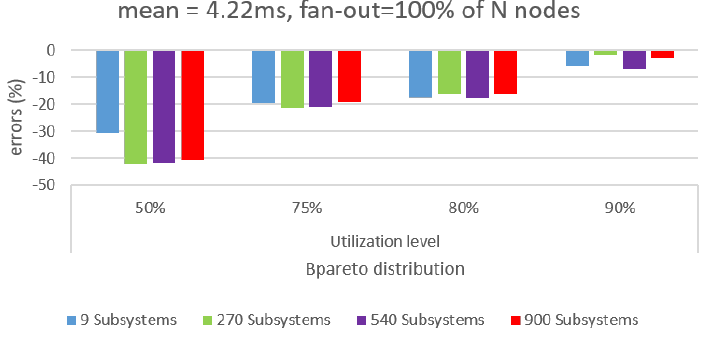
Figure 4. HFJQNs of nine distinct tails associated with all fork nodes, where the black-box method is used in the